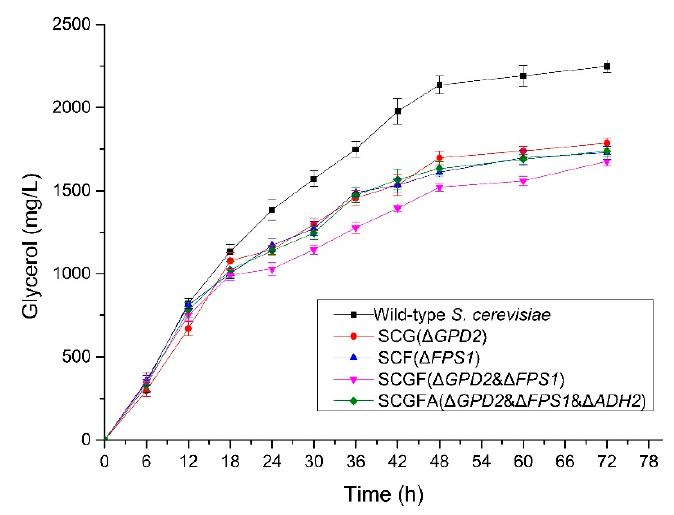
Figure 6. Effect of gene deletion on glycerol contents of S. cerevisiae .